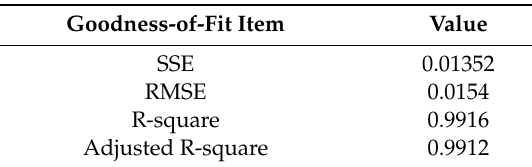
Table 6. Goodness of Fit.